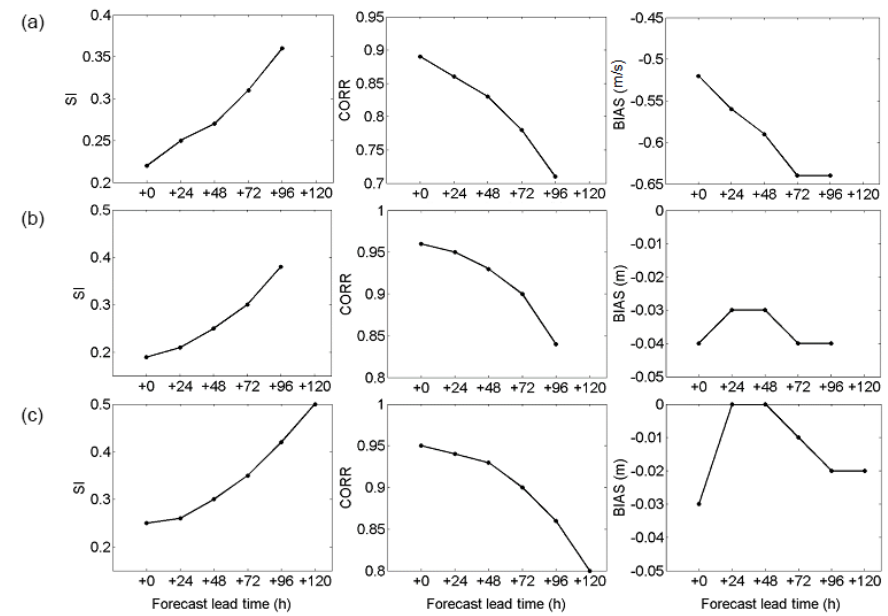
Figure 10. ECMWF U 10 forecast skill evaluated against satellite observations (a) and Med-waves H s forecast skill evaluated against satel- lite (b) and buoy (c) observations, for the full Mediterranean Sea, for a 1-year period (2014).